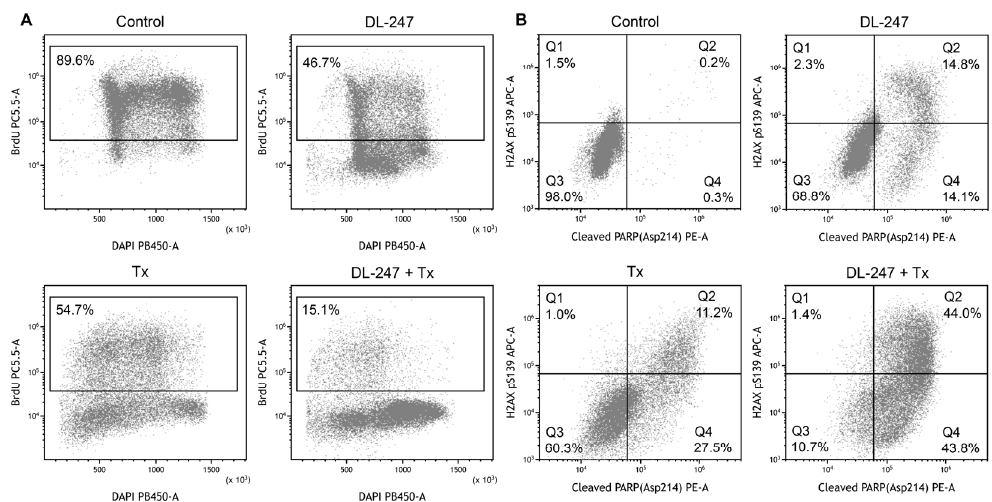
Figure 9. Multiparameter analysis (proliferation, DNA damage and apoptosis) of the synergistic effect of Tx (9 nM) in combination with DL-247 (1.15 µM) in HL-60 cells. Panel A: DAPI vs. BrdU PerCP-Cy™5.5 staining profile. BrdU positive cells are in the inside frame. Panel B: cleaved PARP (Asp214) PE vs. H2AX (pS139) Alexa profile. Squares Q1 + Q2 represent H2AX (pS139) Alexa positive cells, squares Q2 + Q4 represent Cleaved PARP (Asp214) PE positive cells, whereas square Q3 represents H2AX (pS139) Alexa and Cleaved PARP (Asp214) PE negative cells.